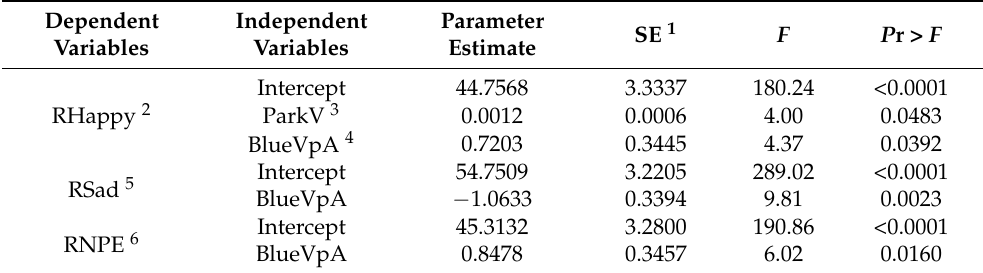
Table 3. Basic characteristics of data on facial expressions, landscape metrics, and ecosystem service values in GBSs of